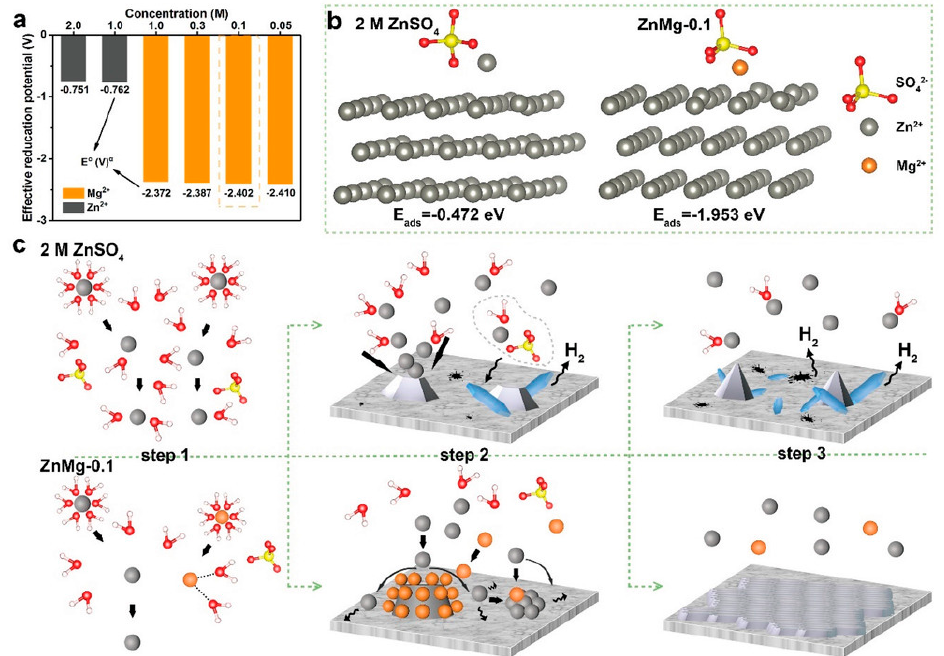
Figure 7. The interaction between the electrolyte and Zn anode. ( a ) Effective reduction potentials of Zn 2+ and Mg 2+ at different concentrations. ( b ) Adsorption of electrolyte ions on a Zn surface and corresponding adsorption energy (Eads). ( c ) Schematics of Zn deposition process in the 2 M ZnSO 4 (top row) and ZnMg-0.1 (bottom row) electrolyte. Reproduced with permissions from Ref. [61]. Copyright © 2021 WILEY-VCH.